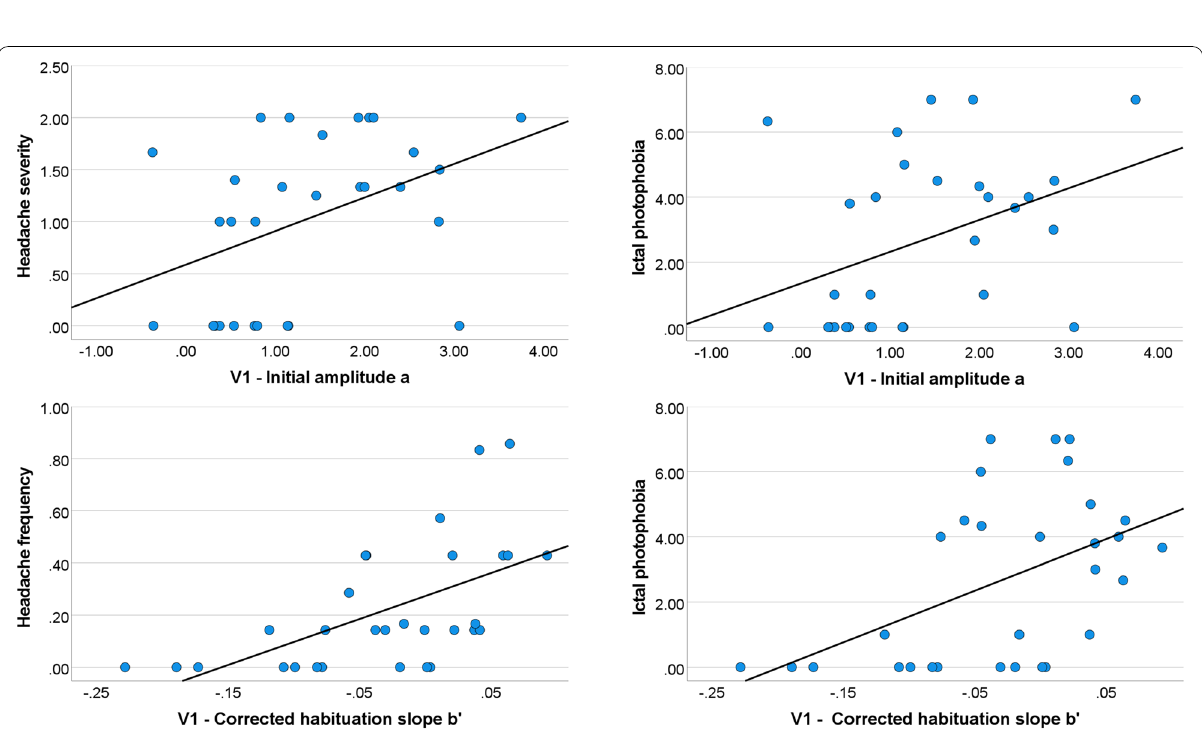
Fig. 5 Correlations between primary visual cortex (V1) activation habituation estimates and diary variables in the patients. The initial amplitude was significantly correlated with headache severity and ictal photophobia, while the corrected habituation slope was significantly correlated with headache frequency and severity, and with ictal